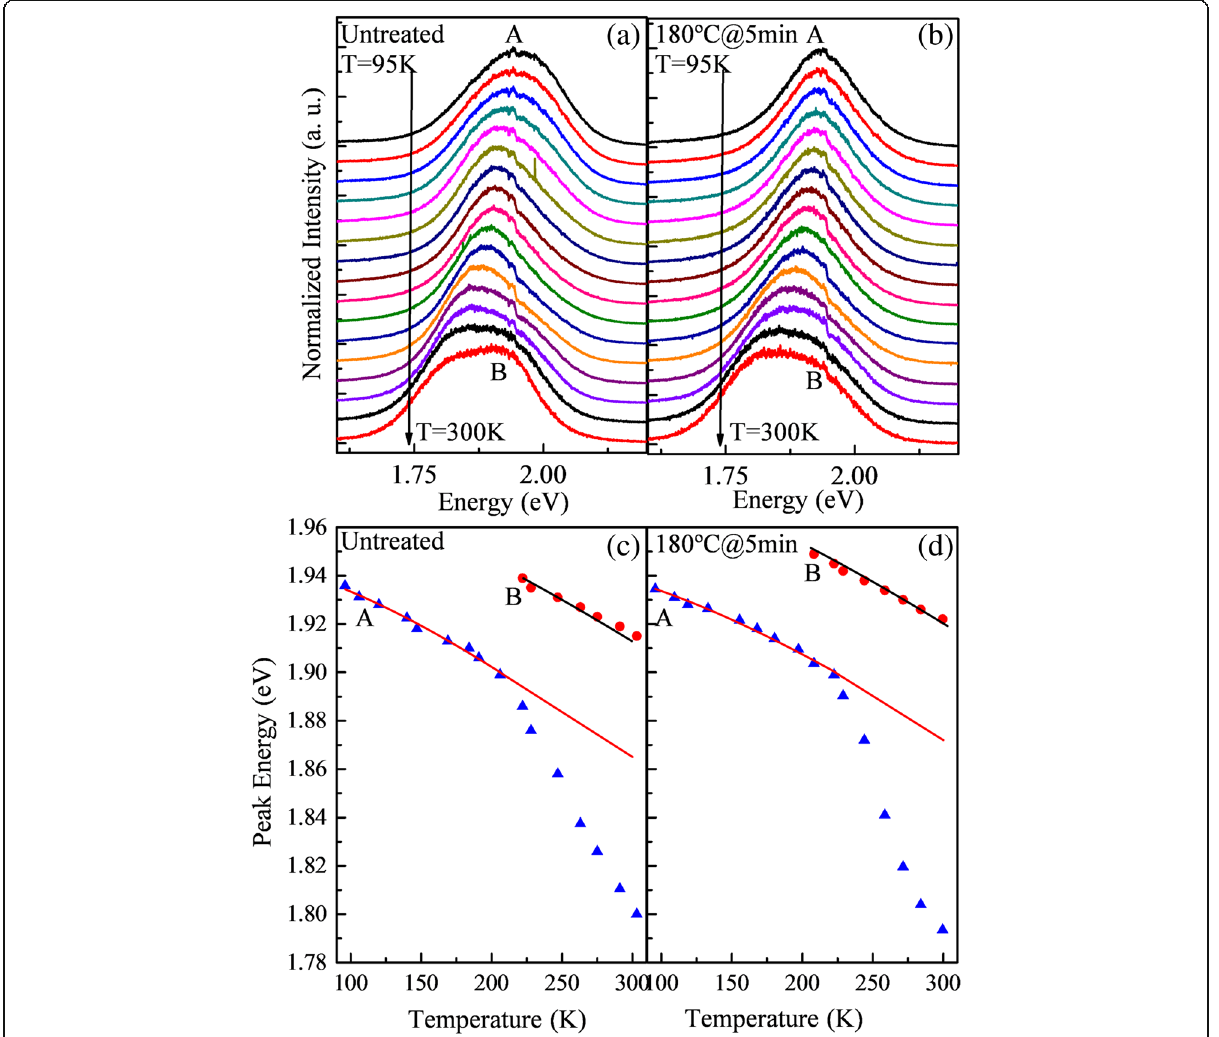
Fig. 4 TDPL of untreated sample ( a ) and sample annealed at 180 °C for 5 min ( b ). Peak position of the A and B spectra components from InP/ ZnS QDs as a function of temperature for the untreated sample ( c ) and sample annealed at 180 °C for 5 min ( d ). Dots are experimental data. Lines are the fits with Varshni ’ s